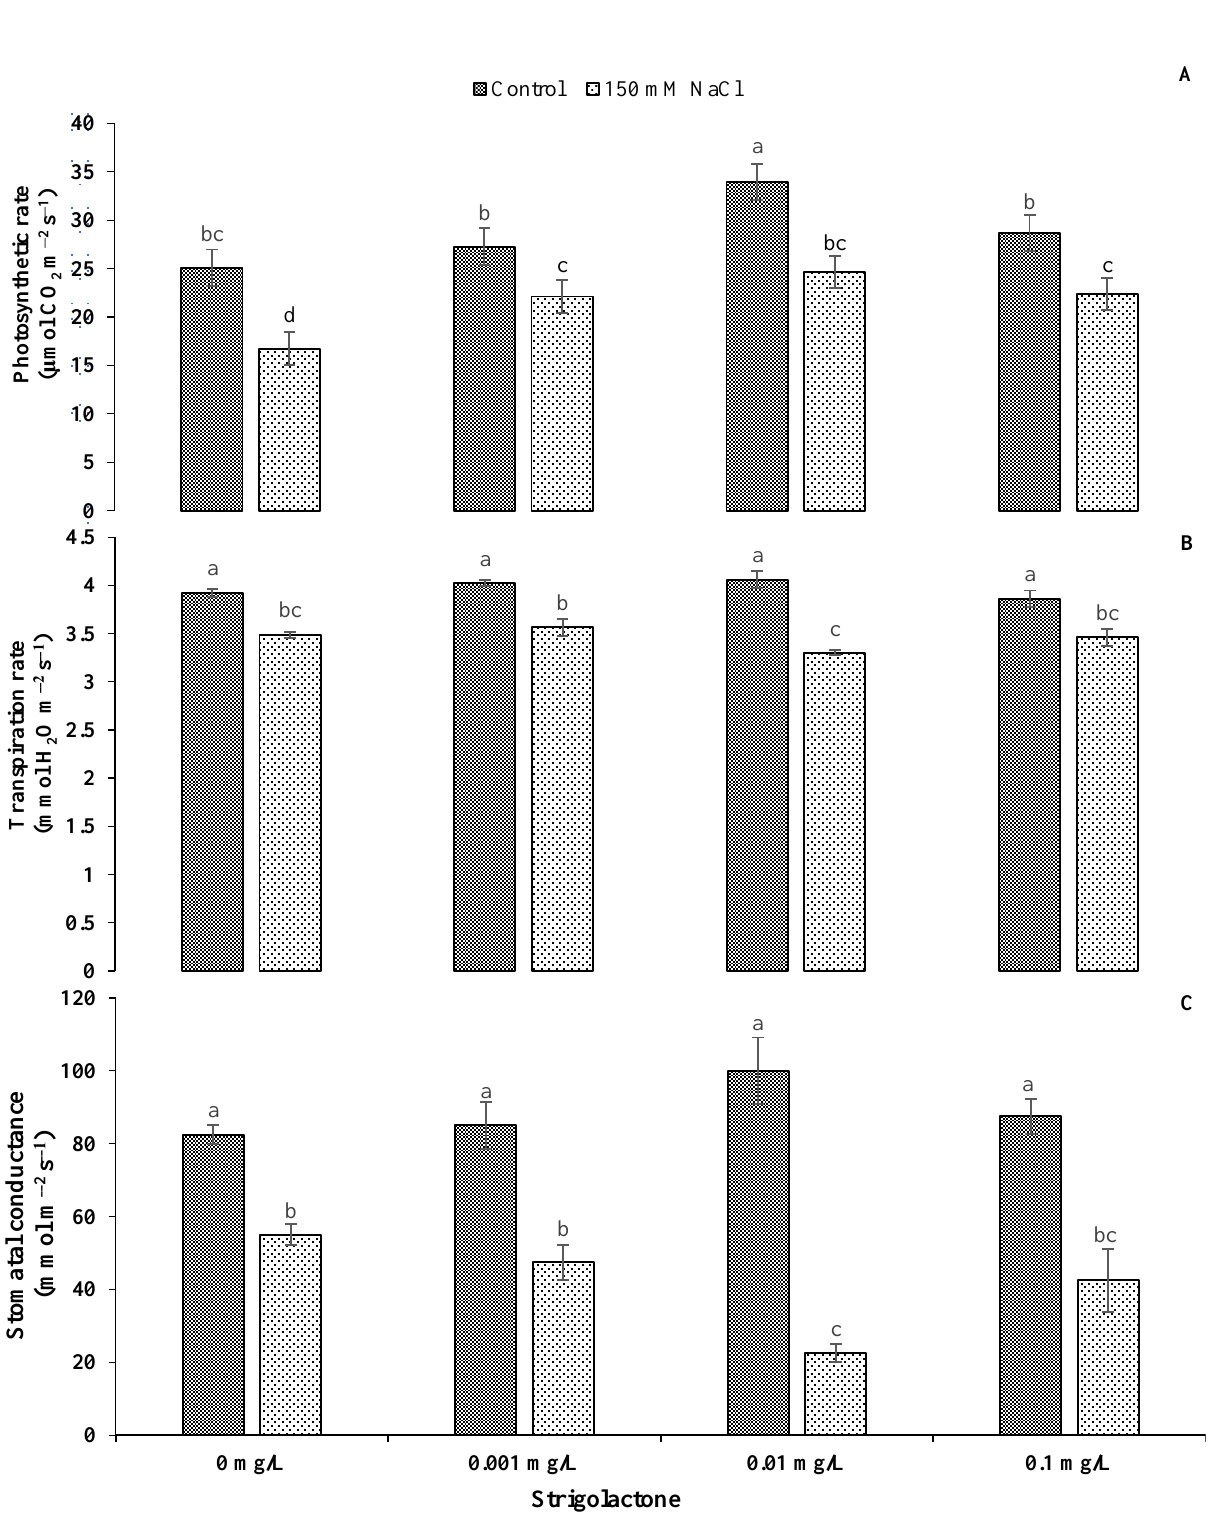
Figure 1. Impact of GR24 on physiological characteristics, i.e., ( A ) photosynthetic rate ( A ), ( B ) transpiration rate ( E ) and ( C ) stomatal conductance (g s ) of ornamental sunflower under control and salt stress conditions. Each vertical bar shows the mean of three replicates. Different letters indicate significant differences among treatments at p ≤ 0.01 according to least significant difference test.